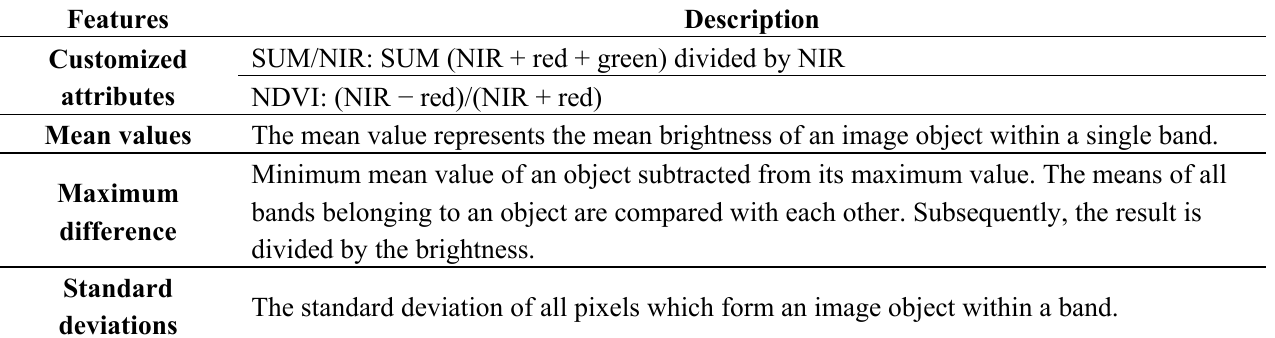
Table 2. Overview of the selected features which were used in the two CART analyses. Only CIR orthoimages were used as input